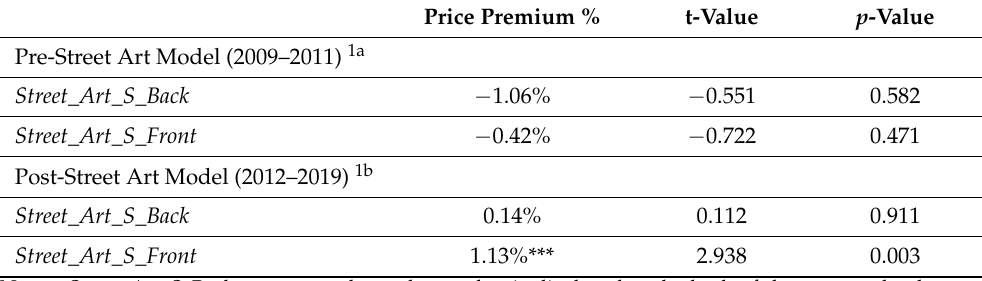
Table 10. Price Premium of Prewar Shophouses in Response to Display of Sculpture. Price Premium % t-Value p